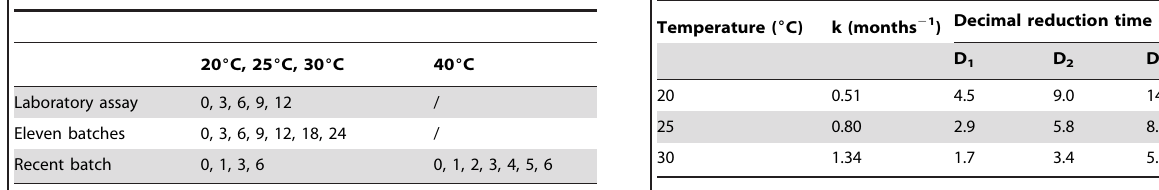
Table 2. Stability testing for the products according to the ICH Guideline Q1A.